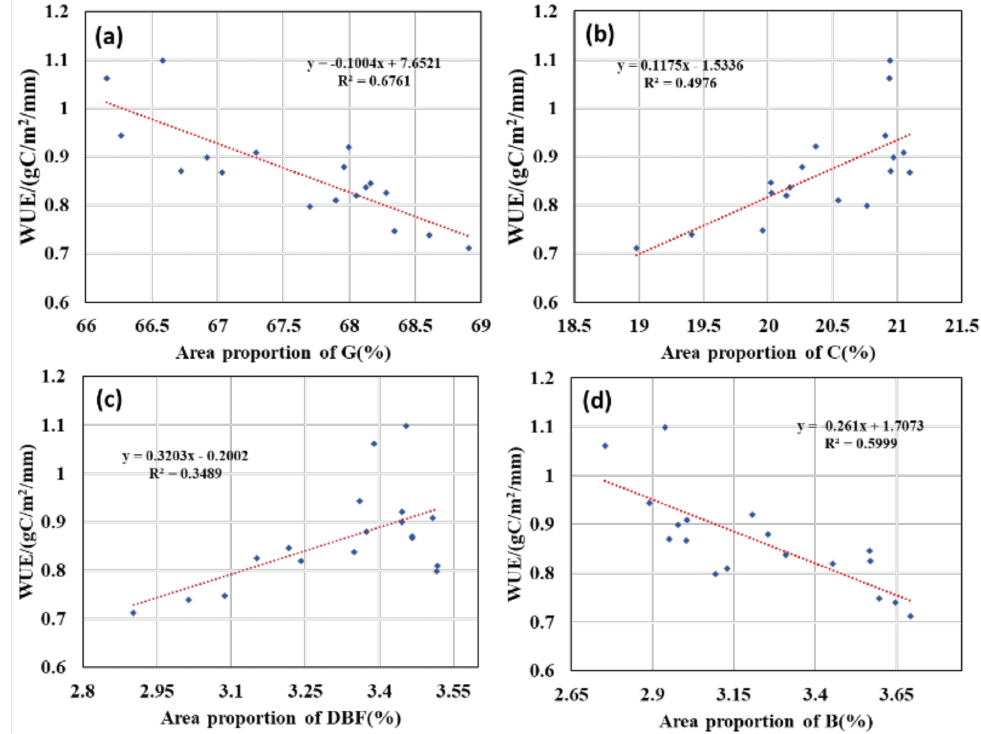
Figure 10. Relationship between four different land cover types and Water Use Efficiency (WUE) in the YRB: ( a ) Grasslands (G); ( b ) Croplands (C); ( c ) Deciduous Broadleaf Forests (DBF); ( d ) Barren